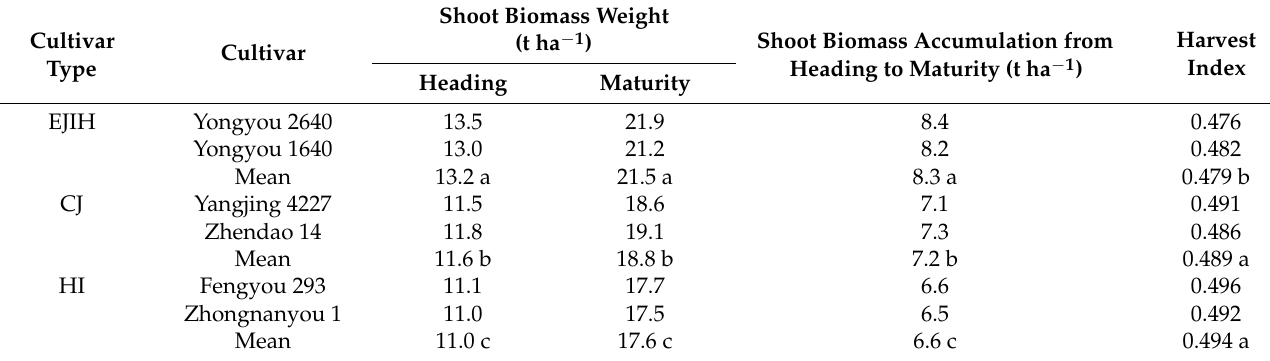
Table 6. Shoot biomass weight and accumulation, and harvest index of rice cultivars.